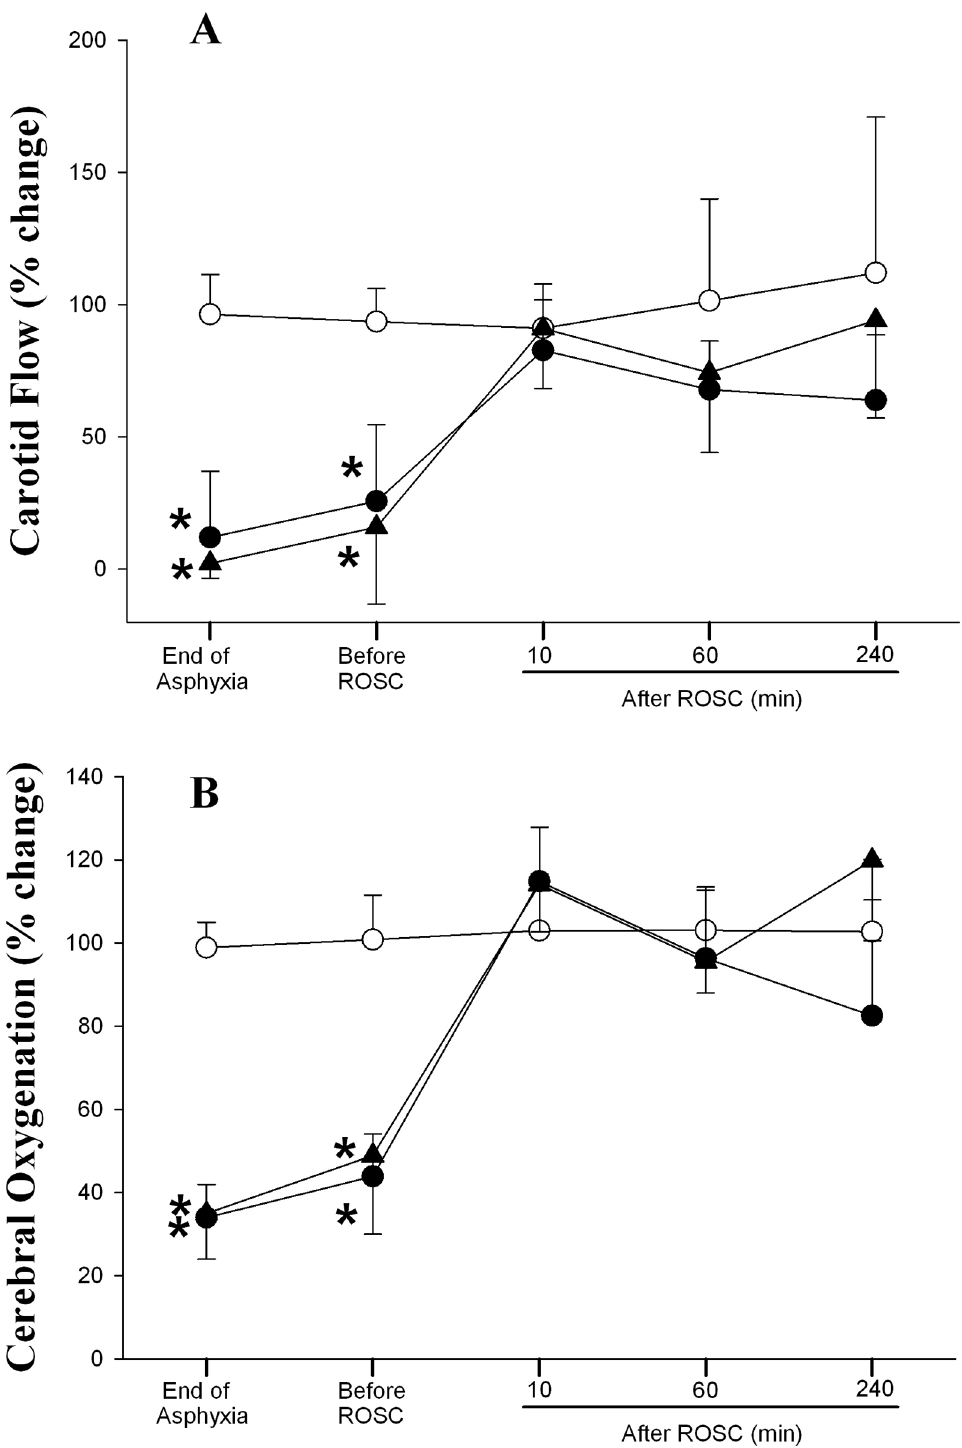
Fig 4. Percent changes from normoxic baseline in (A) carotid flow, and (B) cerebral oxygenation in sham ( ◯ ), SI+CC 90 ( ● ), and SI+CC 120 ( ▲ ) groups during and after resuscitation. Each point represents mean ± SD. * Significantly different from sham-operated group, p < 0.05